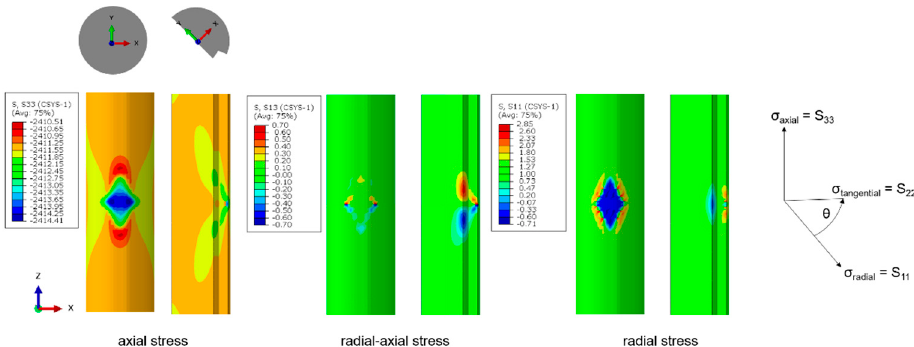
Figure 9. Effects of a fiber − matrix cluster debonding on fiber stresses, top view of the shown C-fiber segment; full fiber ( left ), cut view ( right ), axial stresses in MPa S 33 ( top ), radial-axial shear stress in MPa S 13 ( middle ) and radial stresses in MPa S 11 ( bottom ).